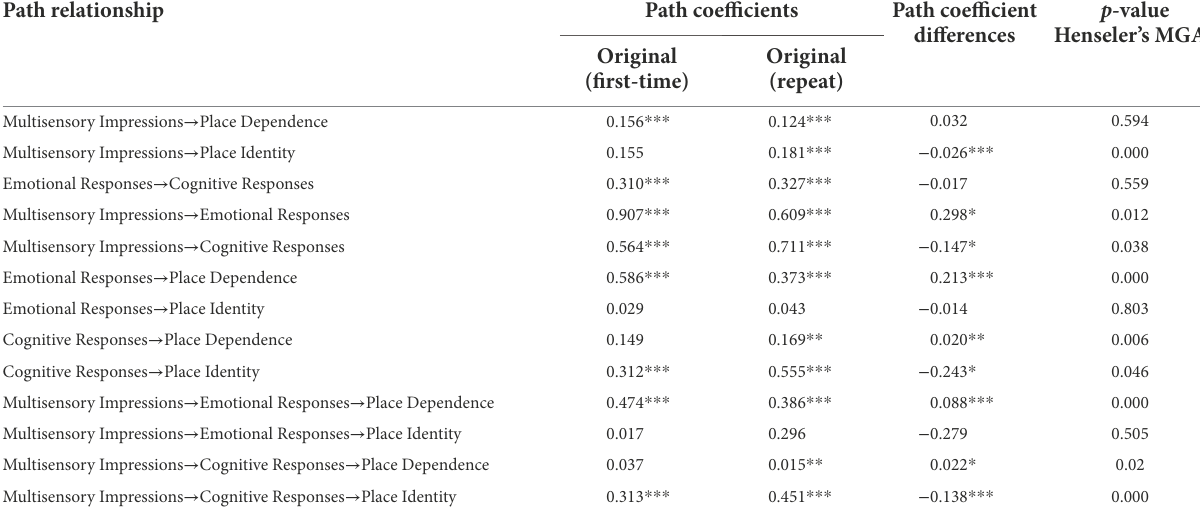
TABLE 4 Hypothetical test and multi-group